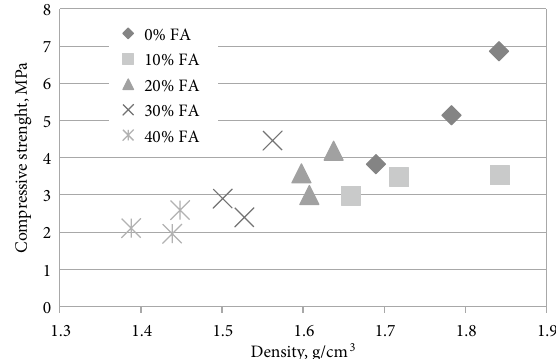
Figure 9. Density and compressive strength dependence on fly ash admixture in